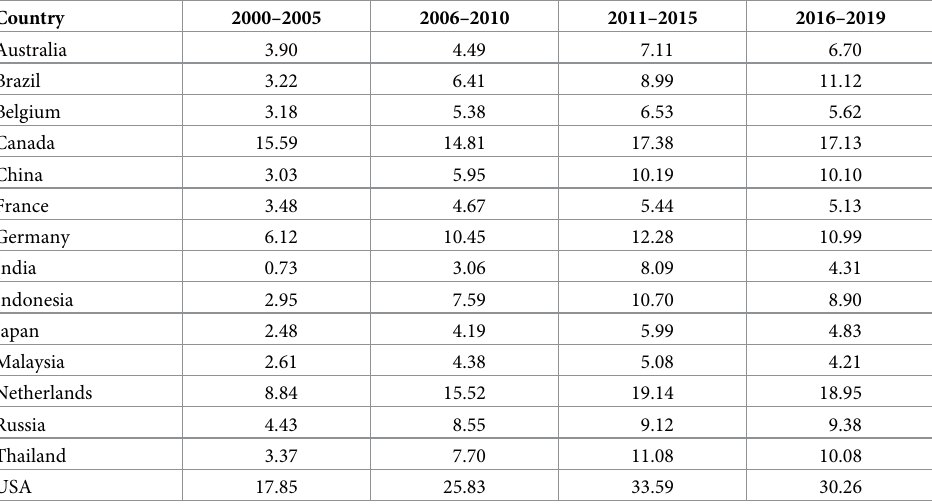
Table 1. Agricultural products export performance of major economies (US billion